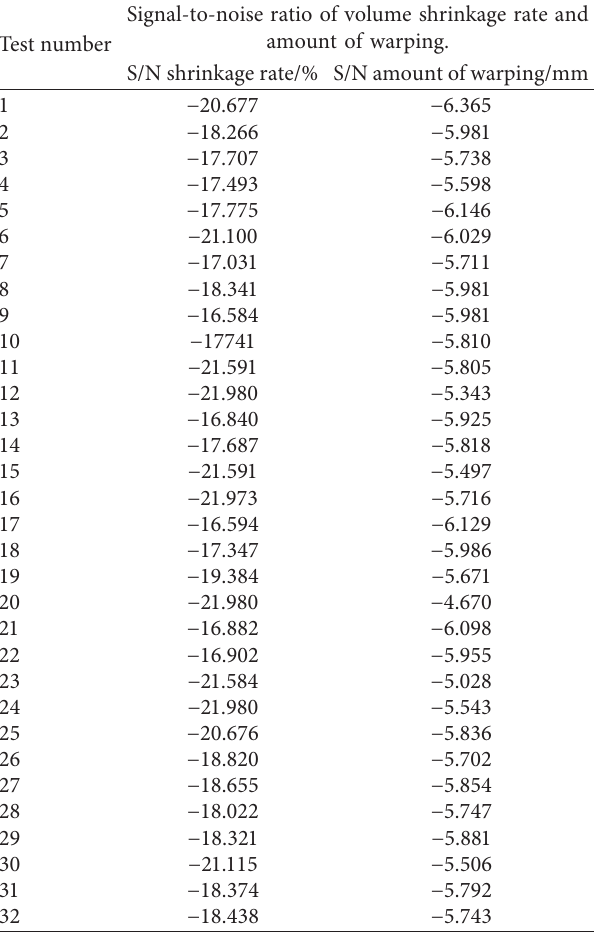
Table 4: Signal-to-noise ratio of volume shrinkage rate and amount of warping. Signal-to-noise ratio of volume shrinkage rate and amount of Test number